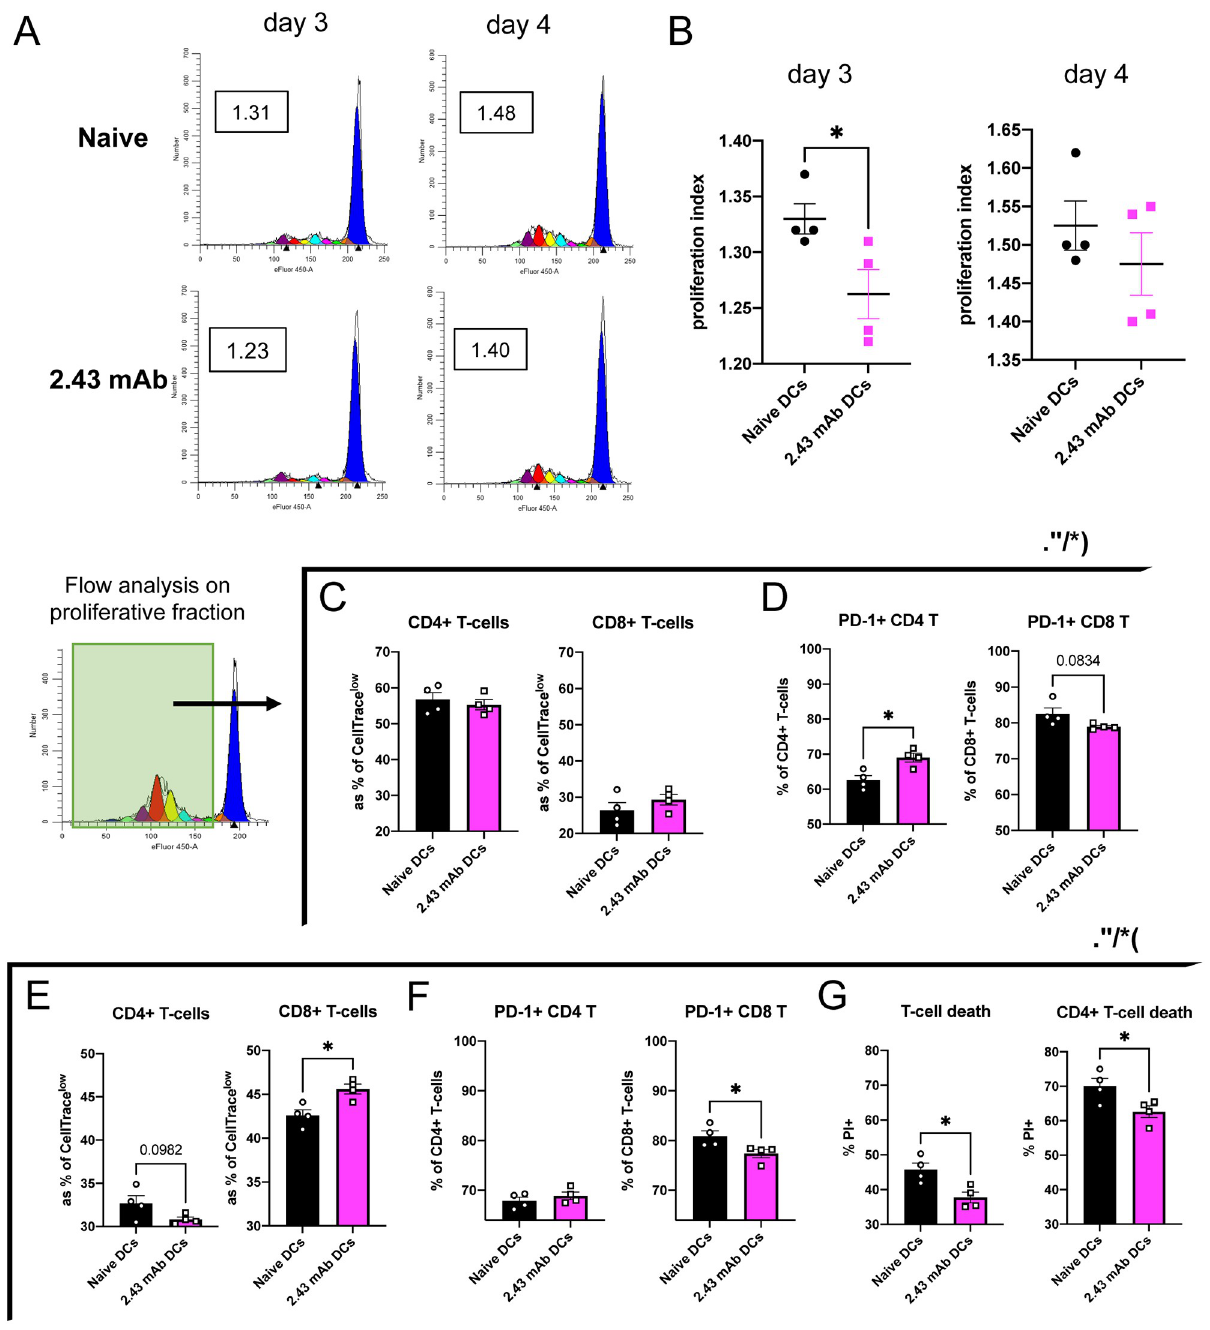
Fig 3. 2.43 mAb-treated DCs induce less proliferation, altered PD-1 expression, and depressed induction of cell death of alloreactive T-cells. BALB/c mice were dosed with 200 μ g of 2.43 mAb antibody intraperitoneally on day -3 and day -1. On day 0, splenic DCs were isolated and plated in an allogeneic MLR. Allogeneic T-cell proliferation was assessed on day 3 and day 4 of co-culture. Data is representative of two independent experiments. (n = 4 per group) (A-B) ModFit Software analysis of CellTrace dye dilutions. (A) Representative histograms depicting proliferation of H2K b + T-cells following stimulation with na ï ve DCs (top) or 2.43 mAb DCs (bottom) on days 3 and 4. Proliferation Index (PI) for representative histograms is boxed. (B) Mean PI for na ï ve or 2.43 mAb DCs shown with SEM. (C-G) Flow analysis of the proliferative fraction of T-cells was determined by first gating on H2K b +CellTrace low T-cells. (C) Mean percent of proliferated T-cells that are CD4+ (left) and CD8+ (right) on day 3 shown with SEM. (D) Mean percent of proliferated CD4+ (left) and CD8+ (right) T-cells expressing PD-1 on day 3 shown with SEM. (E) Mean percent of proliferated T-cells that are CD4+ (left) and CD8+ (right) on day 4 shown with SEM. (F) Mean percent of proliferated CD4+ (left) and CD8+ (right) T-cells expressing PD-1 on day 4 shown with SEM. (G) Mean percent of proliferated T-cells (left) and CD4+ T-cells (right) that are Propidium Iodide+ shown with SEM. Unpaired t tests were used to determine significance between groups. � P <